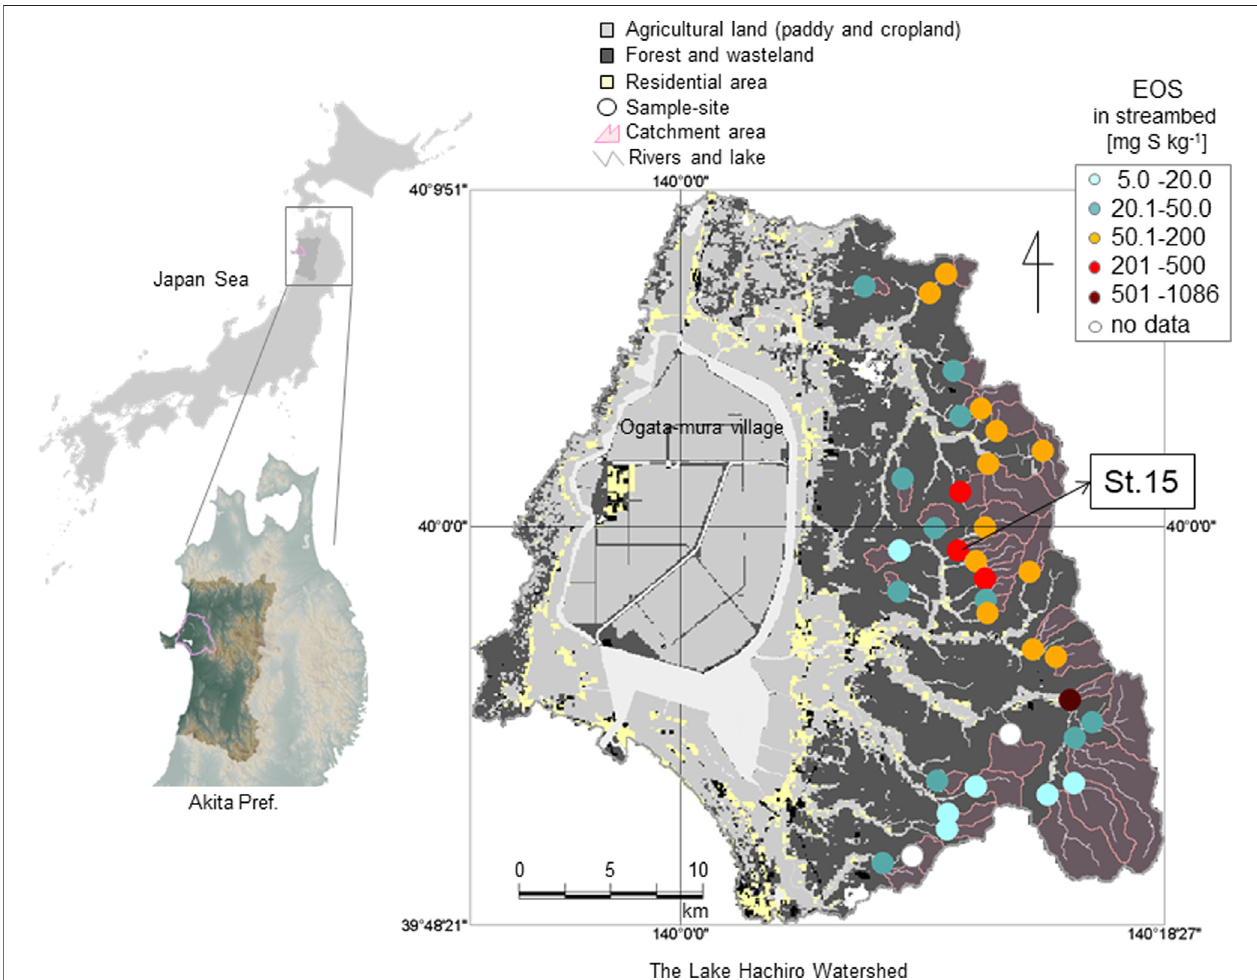
FIGURE 1 | Map of the study site and the distribution of easily oxidizable sulfur (EOS) content in streambed sediments at each headwater catchment in the Lake Hachiro watershed (Hayakawa et al., 2020). St. 15 is the study catchment.